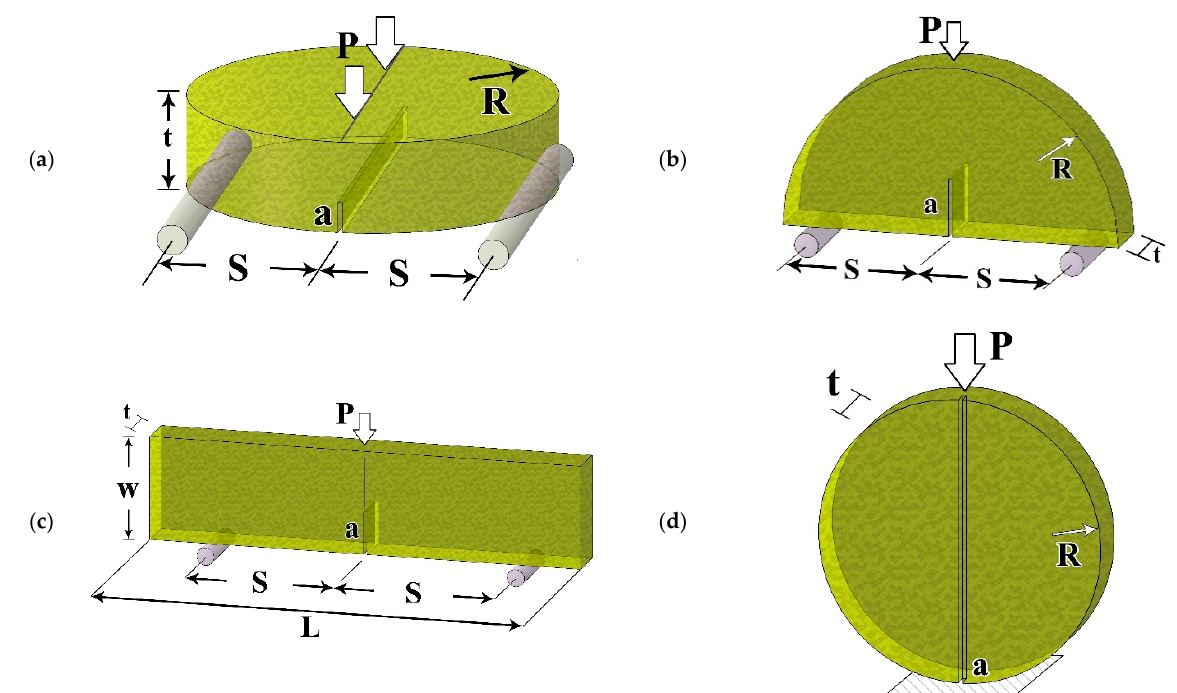
Figure 2. Description of the test specimens employed for mode I fracture toughness testing of asphalt mixture: ( a ) edge notch disc bend (ENDB), ( b ) semi-circular bend (SCB), ( c ) single edge notch beam (SENB) and ( d ) edge notch diametral compression (ENDC).